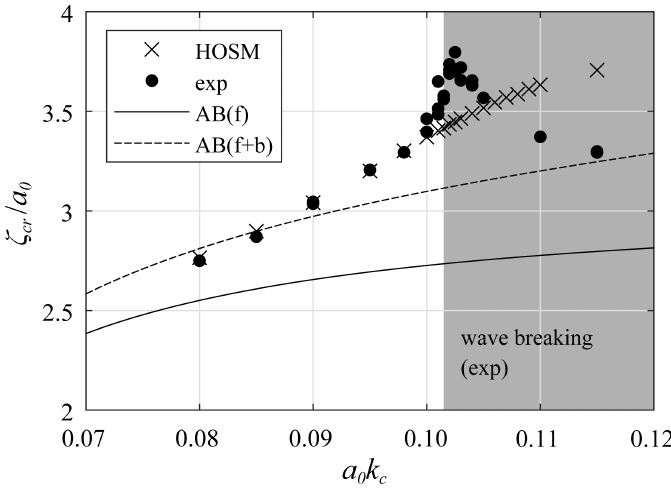
Figure 3. Variation in maximum crest height with the initial wave steepness. f and b indicate the free and second-order bound waves,